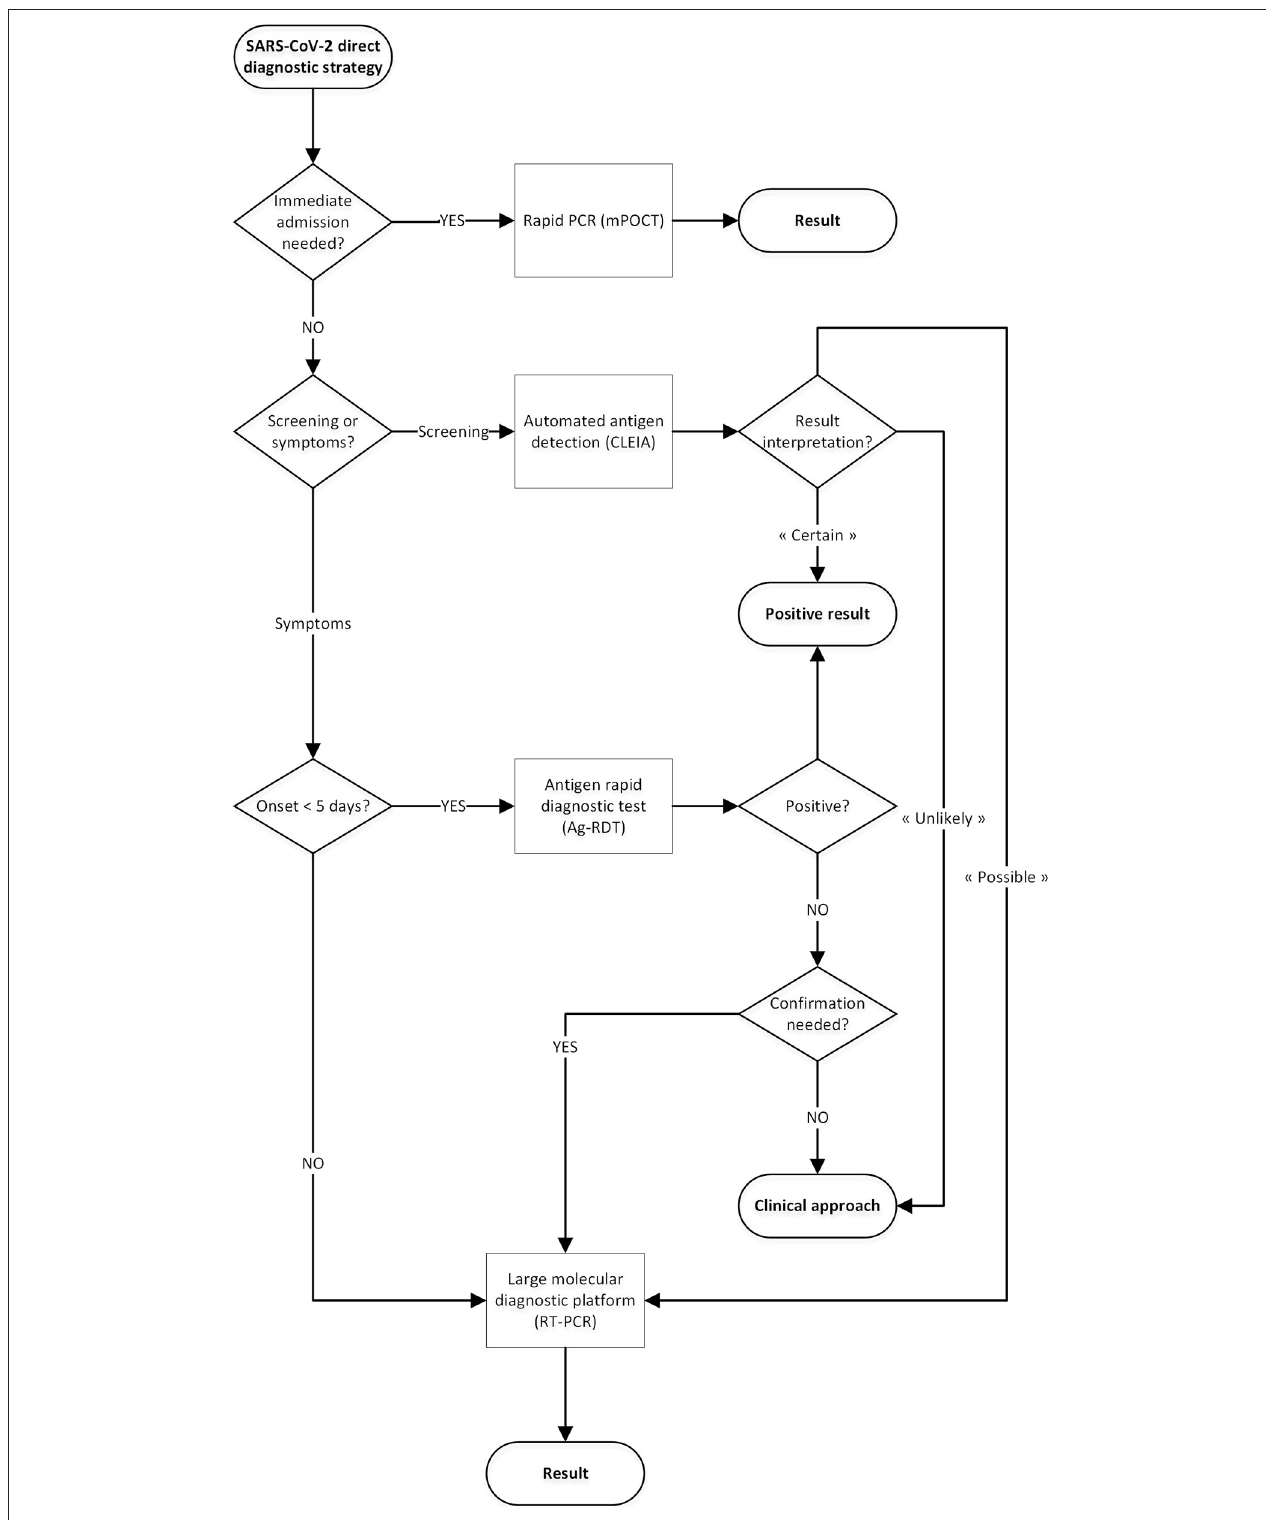
FIGURE 2 | Proposal for a SARS-CoV-2 direct diagnostic decision algorithm.